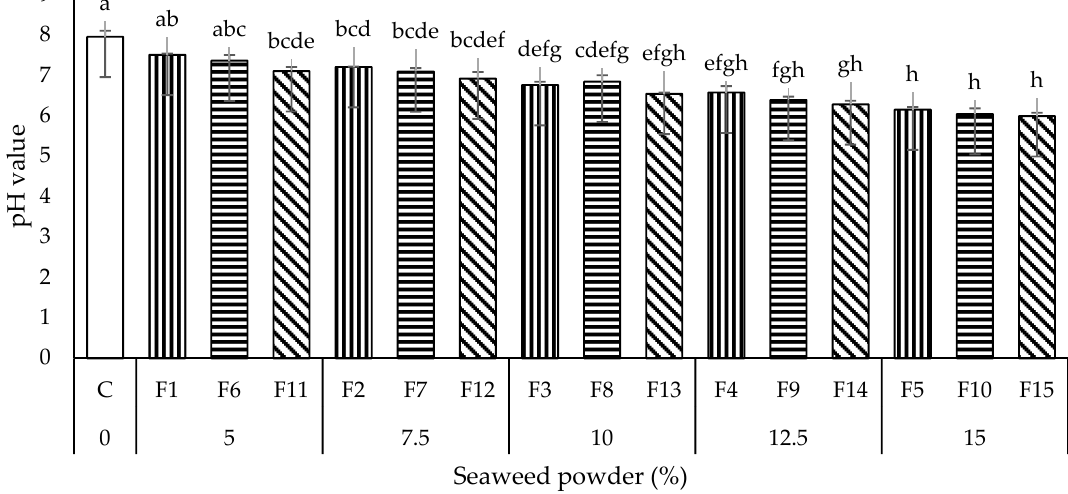
Figure 3. pH measurement of all the noodles samples. Data are presented as mean ± standard deviation ( n = 3). a–h with different superscripts indicate the significant difference among the noodles samples (Tukey’s HSD, p < 0.05). Bars with vertical, horizontal, and diagonal patterns = wheat flour: potato starch ratios of 9:1, 8:2, and 7:3, respectively.